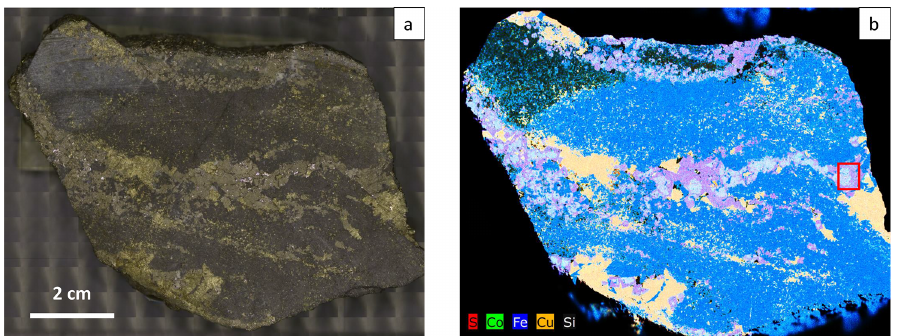
Figure 10. Cut of rock sample (a) and element distribution map revealed by µ-EDXRF (b)